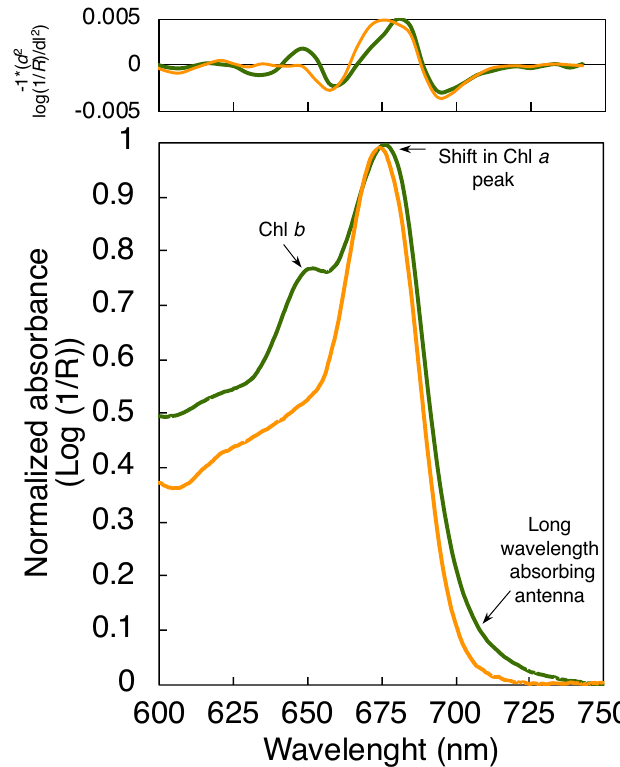
Figure 2. Spectroscopic optical properties of Orbicella faveolata and Ostreobium spp. Comparison of the estimated in vivo light absorption spectra of the coral Orbicella faveolata (orange solid line) and that of the chlorophyte endolithic algae Ostreobium spp. (green solid line) living within the coral skeleton of this species. The spectrum of Ostreobium spp. was obtained after removing the coral tissue with water and pressurized air. Absorption spectra were normalized to the maximum peak of absorption of Chl a in the red band of the spectrum. Top panel represents second derivative analysis of the absorption